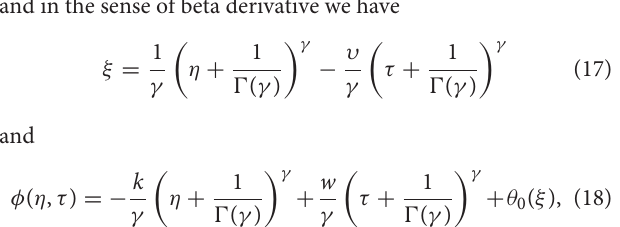
Frontiers in Physics |